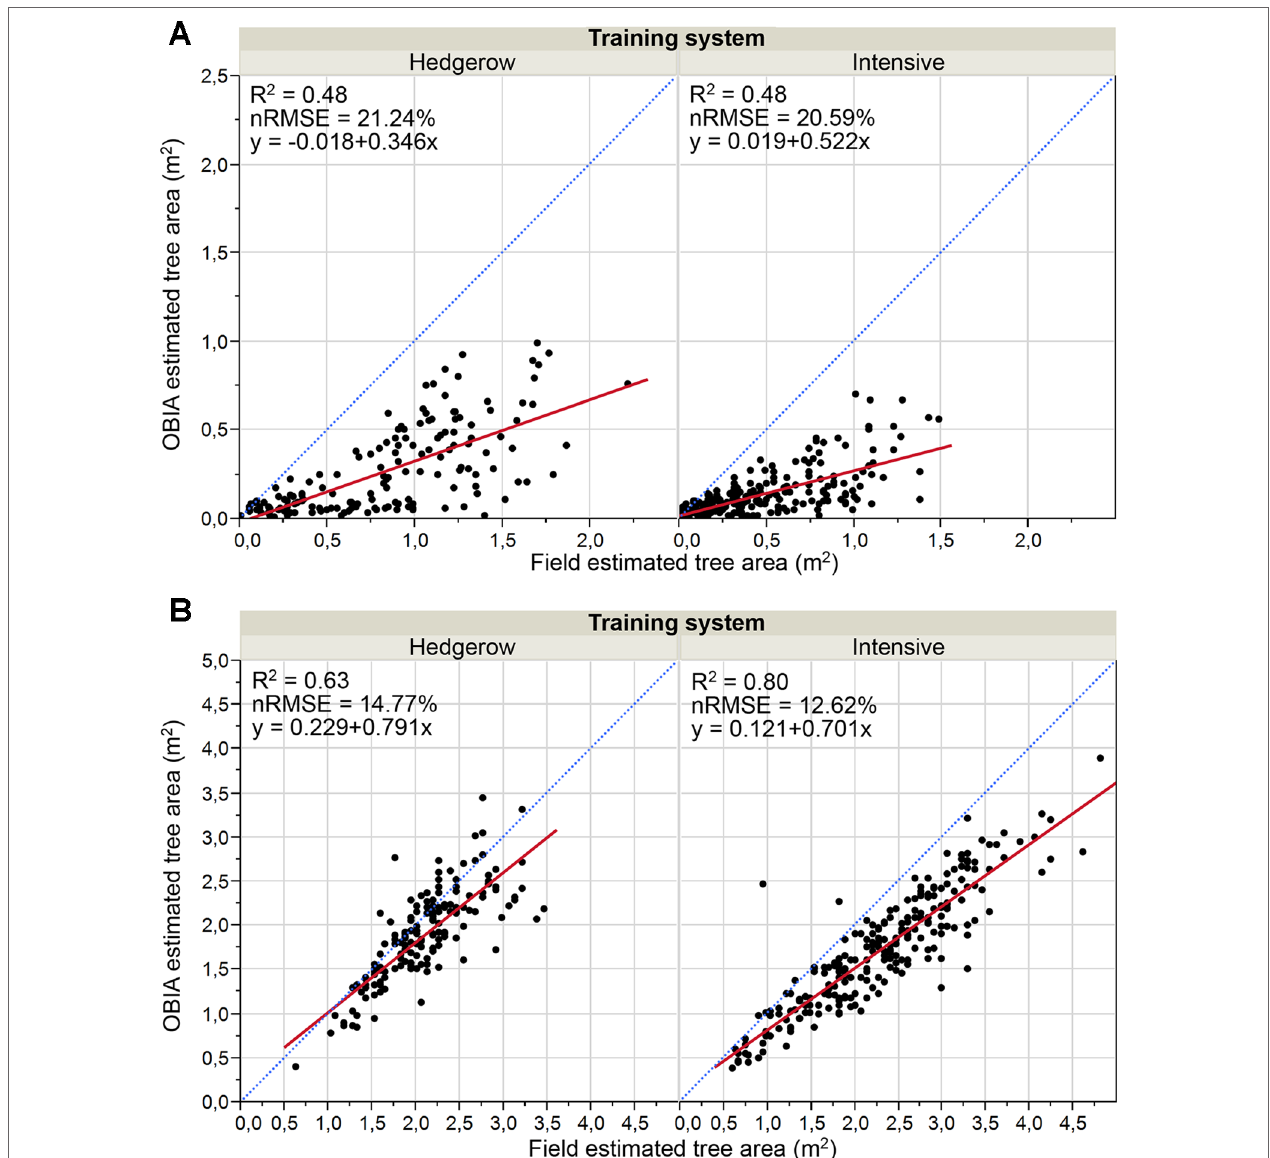
FIgUrE 8 | Graphical comparisons of Point cloud-OBIA estimated and field estimated crown area by training system in: (A) January 2017, 15 months after olive plantation; (B) January 2018, 27 months after olive plantation. The normalized root mean square error (nRMSE) and coefficient of determination (R 2 ) derived from the regression fit are included for every scenario (p 0.0001). nRMSE was computed as the percentage of the average of measured values of tree variables. The red solid line is the fitted linear function and the blue dashed line represents the 1:1 line.